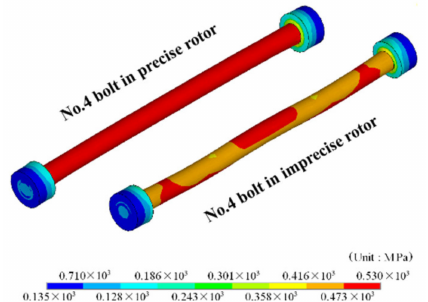
Figure 4. Stress and deformation of rod in both rotors.